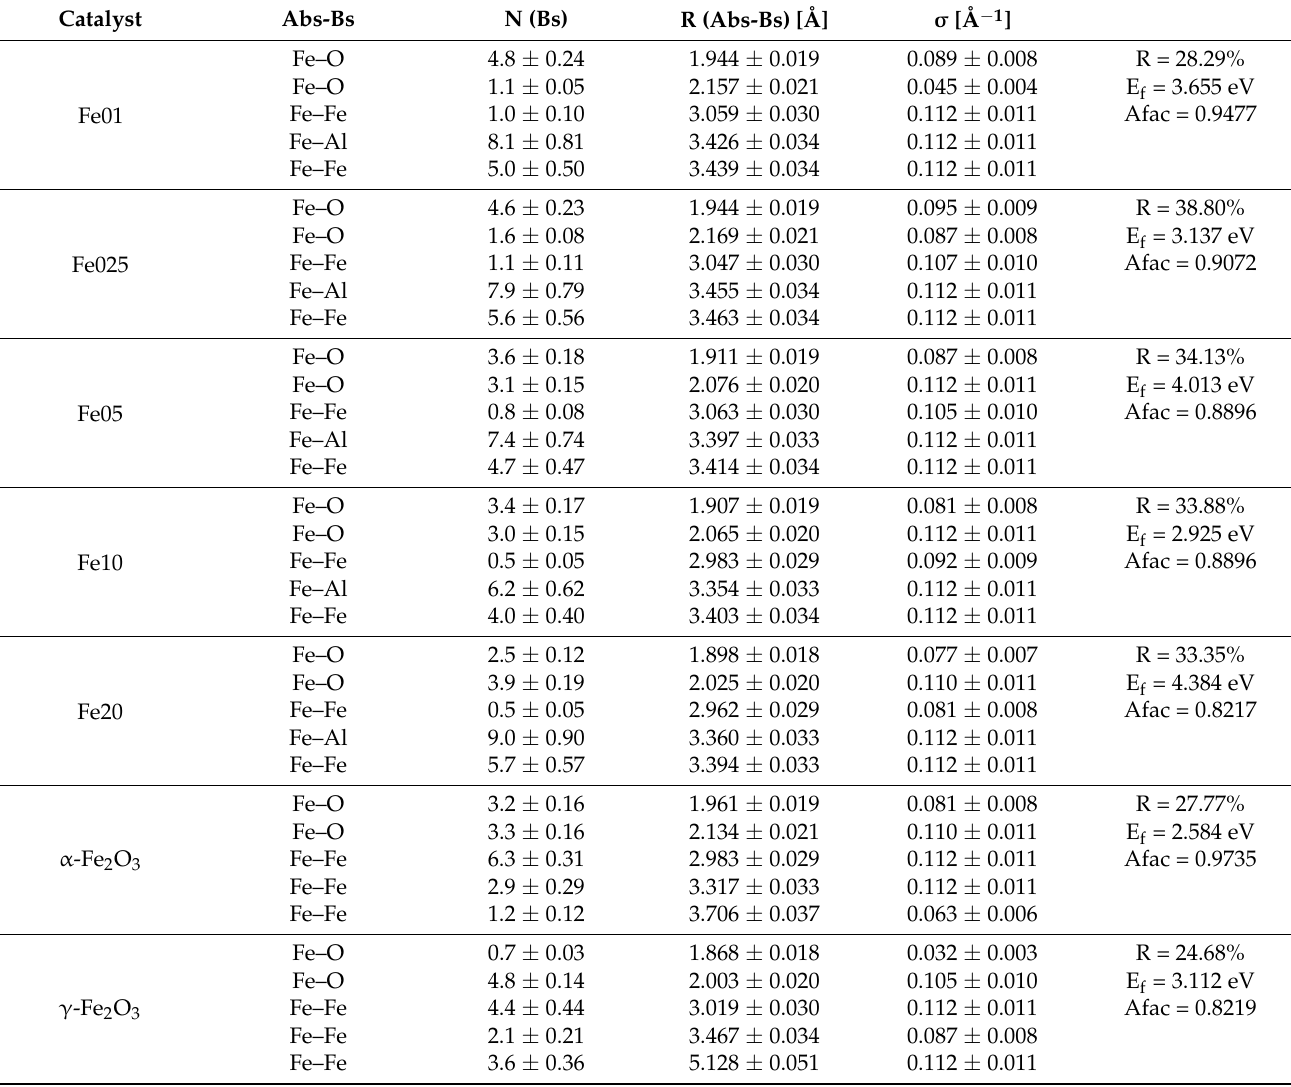
Figure 11. Fourier-transformed EXAFS spectra of Fe01 to Fe20 and the corresponding fits. Table 5. Structural parameters obtained by EXAFS analysis of the catalysts Fe01–Fe20 and the α - and γ -Fe 2 O 3 references; Abs = absorbing atom; Bs = backscattering atom; n(Bs) = number of back- scattering atoms; r(Abs-Bs) = distance of absorbing to backscattering atom; σ = Debye–Waller-like factor; R = fit index; E f = Fermi energy; Afac = amplitude reducing